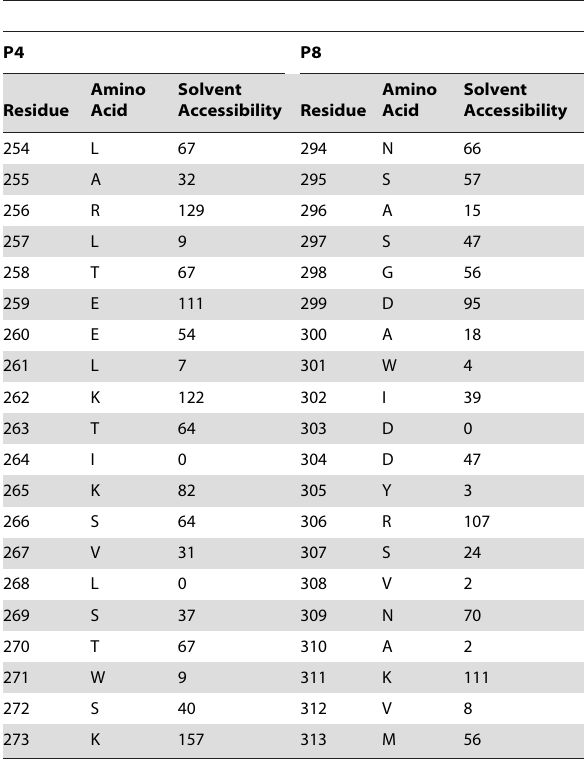
Table 2. The solvent accessibility of the residues from peptides P3 and P7, measured in water exposed surface in A˚ 2